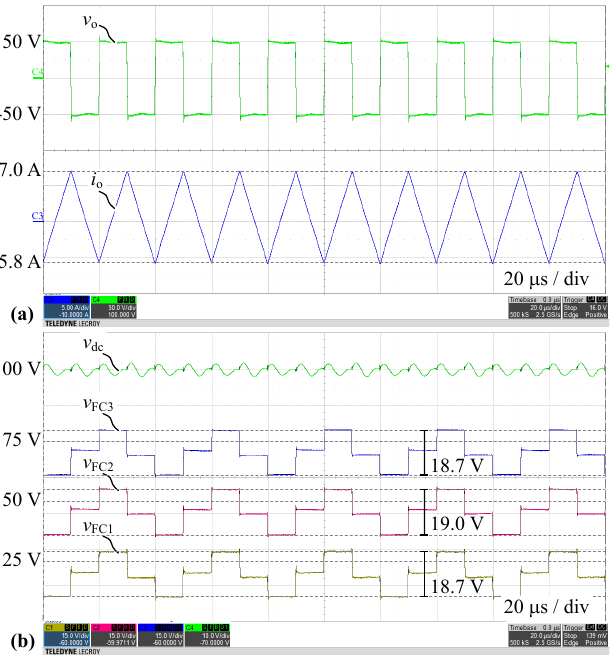
Figure 14. Measured waveforms for Q2L-5L-FCC in configuration 1 (cid:13) with OL balancing and trian- gular current ( I o,max = 7.0A, I o,min = − 5.8A): ( a ) Output voltage v o and current i o , ( b ) DC-link capacitor voltage v dc and FC voltages v FC{1,2,3} . A delay time T delay = 100ns is